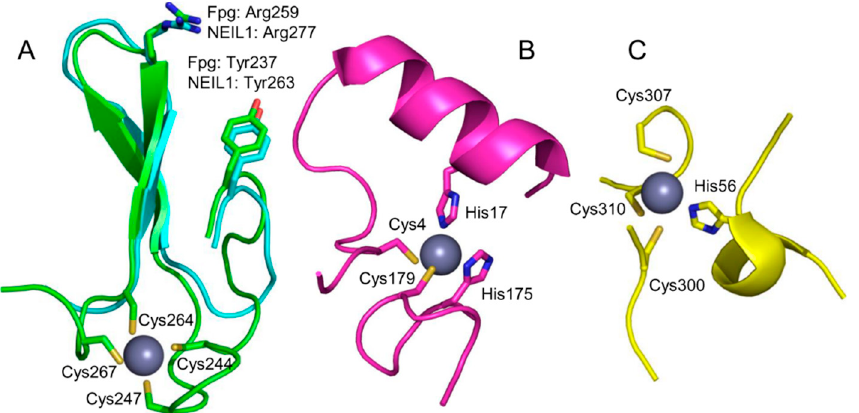
Figure 3. Zinc-binding motifs and their structural analogs in DNA glycosylases. ( A ) Superimposed zinc finger of E. coli Fpg (green; PDB ID 1K82 [72] ) and zincless finger of human NEIL1 (cyan, PDB ID 5ITT [79] ). ( B ) Zinc snap motif of E. coli Tag (PDB ID 1NKU [80] ). ( C ) Zinc linchpin motif of mouse MUTYH (PDB ID 7EF8 [81] ). The Zn 2+ ion is shown as a gray ball. Zinc-binding residues are shown as sticks; the rest of the protein is omitted for clarity.